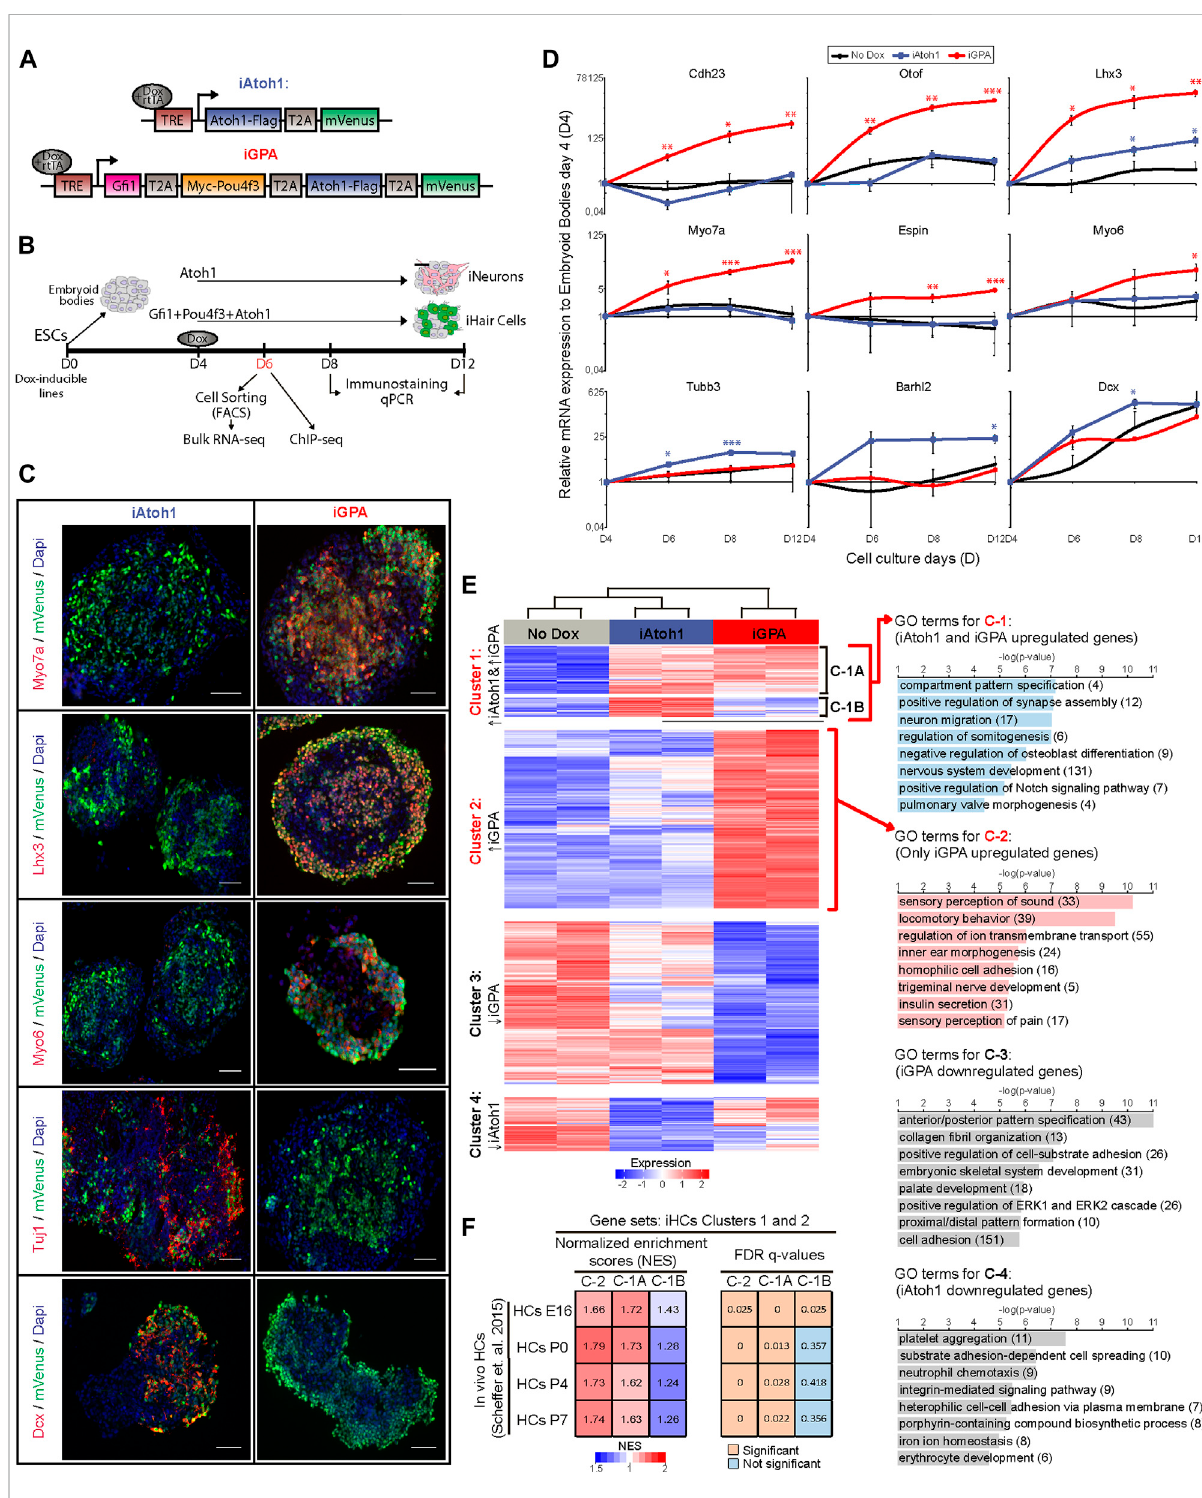
Atoh1 drives neuronal differentiation while G fi 1 + Pou4f3 + Atoh1 drives HC differentiation. (A) Dox inducible tagged TF constructs used in this study for iAtoh1 and iGPA lines. T2A, 2A self-cleaving peptide derived from thosea asigna virus, TRE, tetracycline responsive element, rtTA, reverse tetracycline transactivator. (B) Schematic differentiation protocol for TF induction timeline in EBs and analyses time-points. (C) Representative images obtained from immunostaining of HC (Myo7a, Lhx3, and Myo6) and neuronal (Tuj1, Dcx) markers (red) in induced EBs at day 8